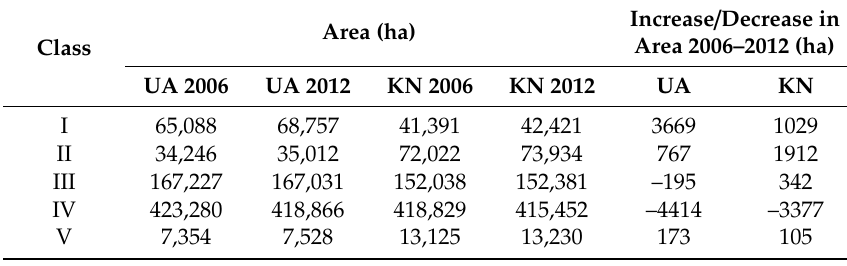
Table 8. Comparison of the UA and KN data.